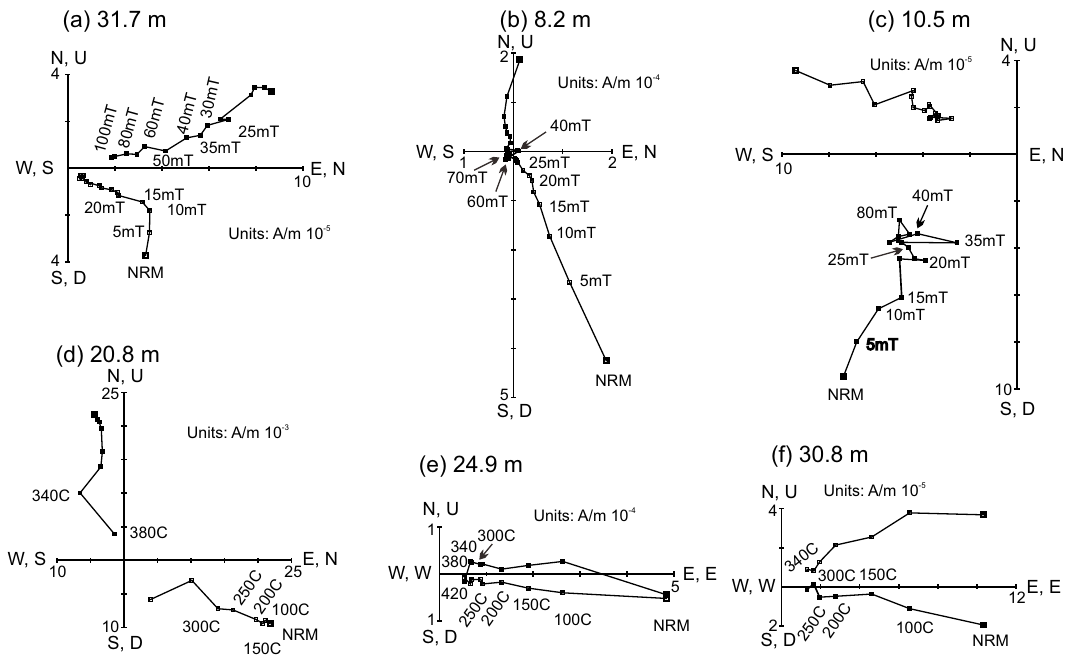
Figure 6. Representative demagnetization data of samples from the section studied. Open and closed squares indicate the vertical and horizontal components, respectively.